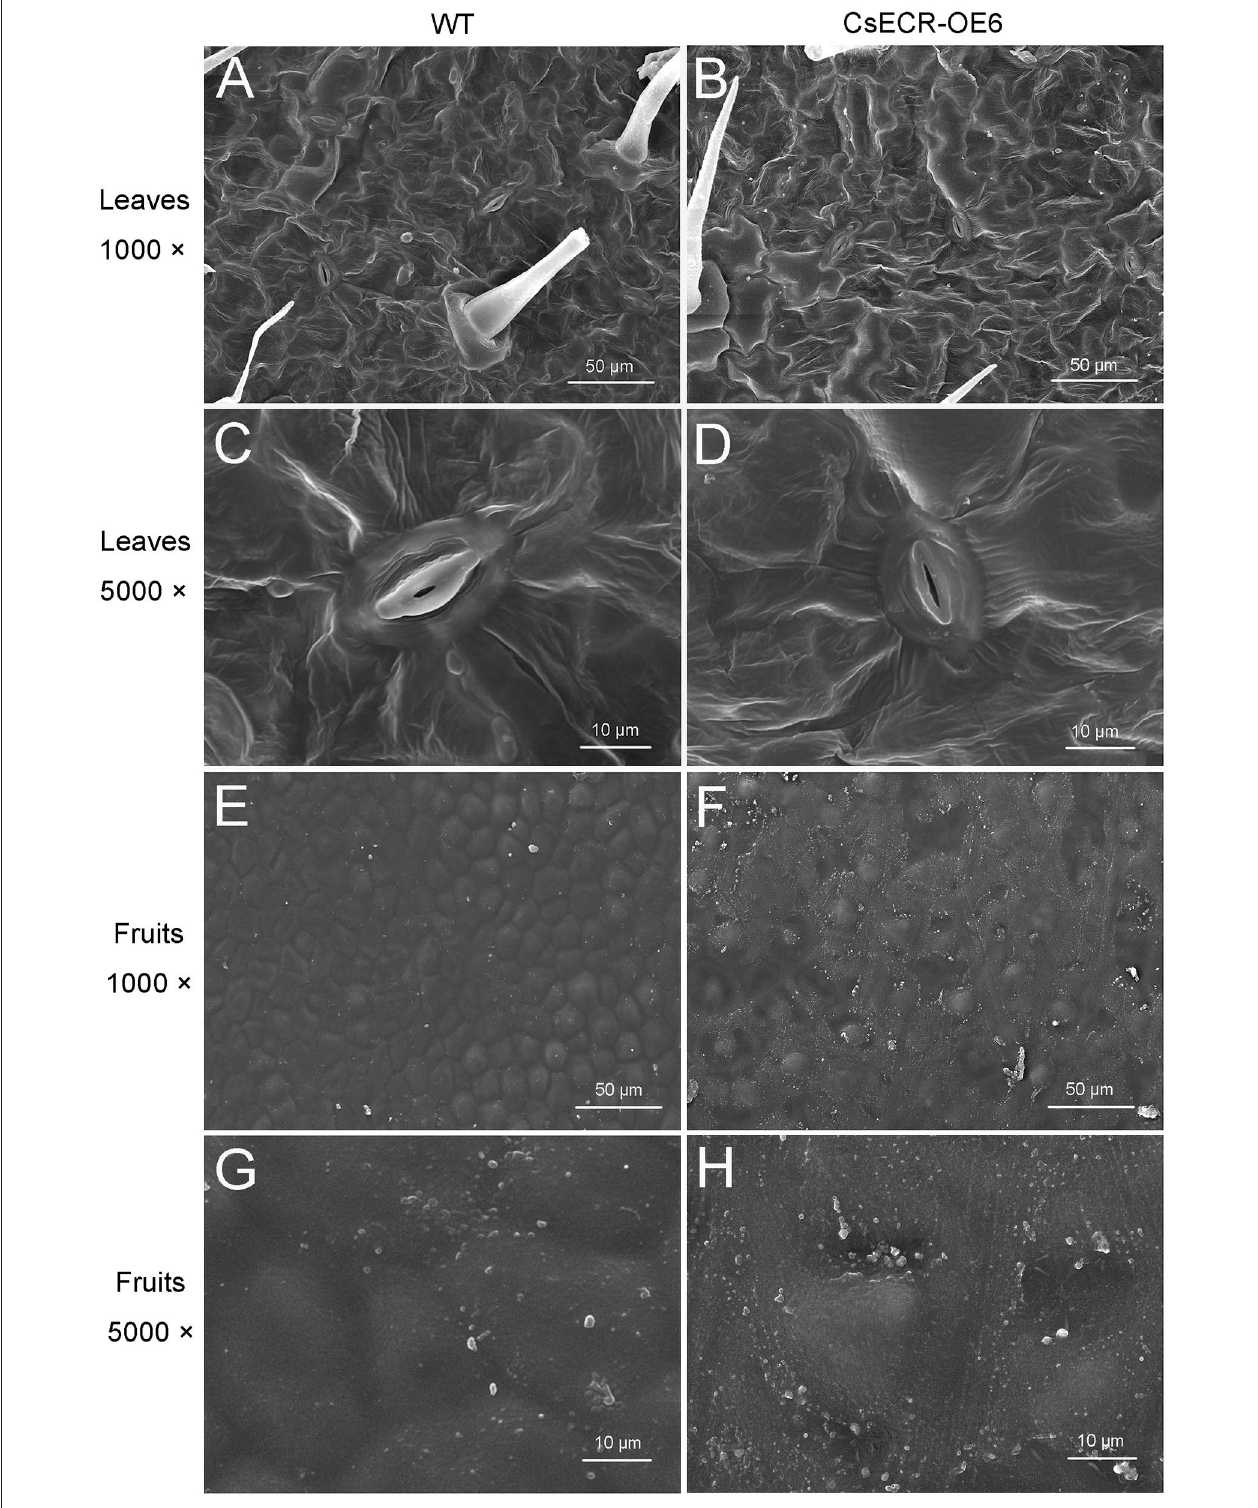
FIGURE 4 | Scanning electron micrographs of cuticular waxes on the surfaces of leaves and fruits in the WT and transgenic tomato (CsECR-OE6). (A,B) The abaxial surfaces of leaves in the WT and transgenic tomato line were imaged at × 1,000 magnification. (C,D) The abaxial surfaces of leaves in the WT and transgenic tomato line were imaged at × 5,000 magnification. (E,F) The surfaces of fruits in the WT and transgenic tomato line were imaged at × 1,000 magnification. (G,H) The surfaces of fruits in the WT and transgenic tomato line were imaged at × 5,000 magnification.